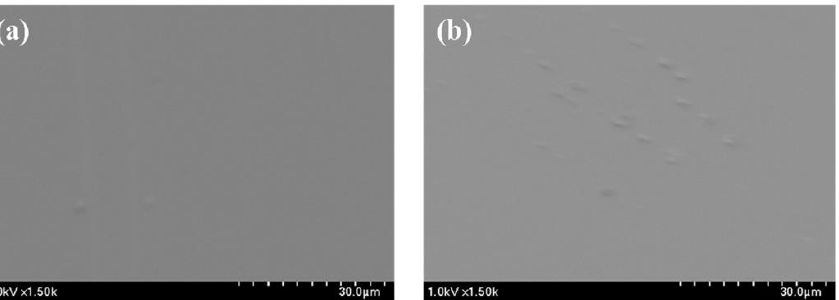
Figure 1. FE-SEM images of the pullulan/TEMPO cellulose nanofibrils (PULL/TOCNs)-based composite film with varying carbon nanotube (CNT) contents of ( a ) 0.5 wt.% and ( b ) 5 wt.%. The micromorphology of the PULL composite films was identified by AFM (Figure 2a,b).